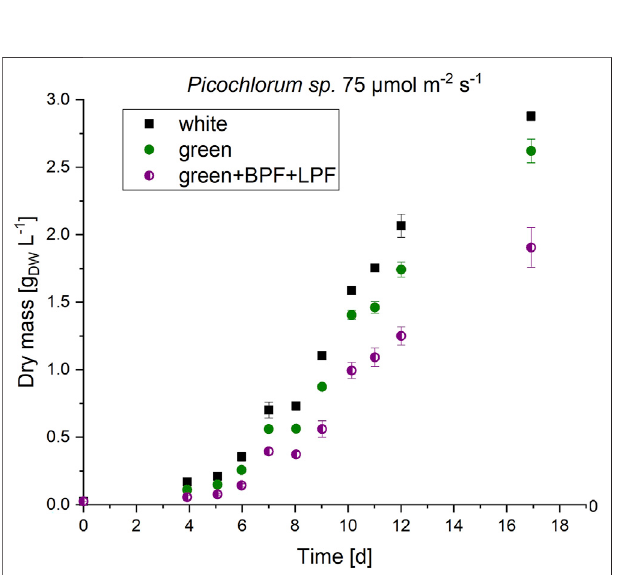
FIGURE 5 | Biomass formation of Picochlorum sp . at 75 μ mol m − 2 s − 1 irradiationwithwhite,greenanddouble-bandwidthdiminishmentgreen+BPF (band-pass fi lterB13)+LPF(long-pass fi lterO540).Experimentswerecarried out in